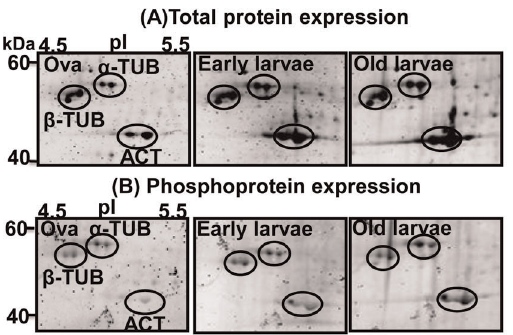
Figure 6. A close view of differential phosphorylation of cytoskeleton proteins (spots marked in circle) in fertilized ova and larvae of Neanthesarenaceodentata.